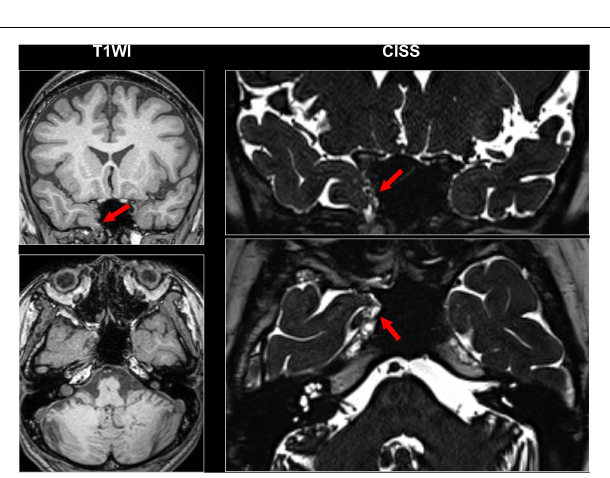
FIGURE 2 | A case with drug-resistant temporal lobe epilepsy and encephalocele. Constructive interference in steady-state (CISS) imaging was helpful for detection by enhancing the contrast between brain parenchyma and cerebrospinal